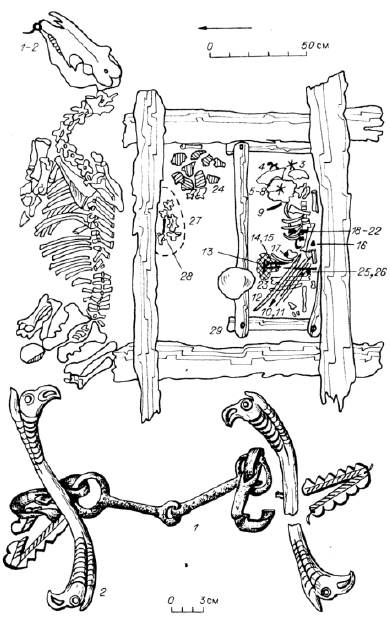
Figure 3. Plan of Kurgan 22, Yustyd XII and illustration of the bronze bit and wooden psalia of the horse bridle. Numbering is original with Kubarev and references the locations of materials he excavated. Adapted from (Kubarev 1991, Pl. L1).